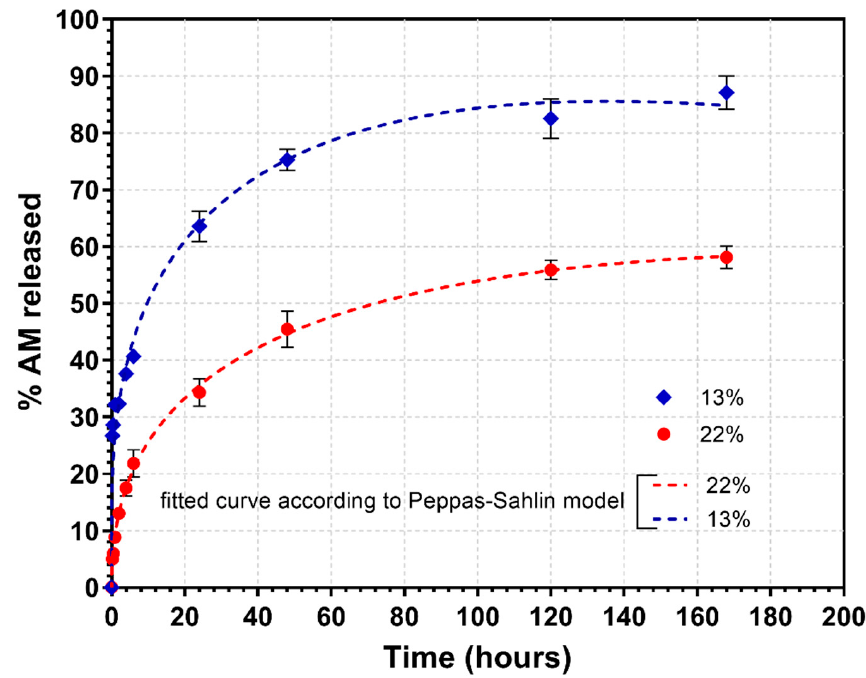
Figure 7. In vitro release profiles of AM from Plx- g -CMP hydrogels obtained at two concentrations (13% and 22%, w / v ).